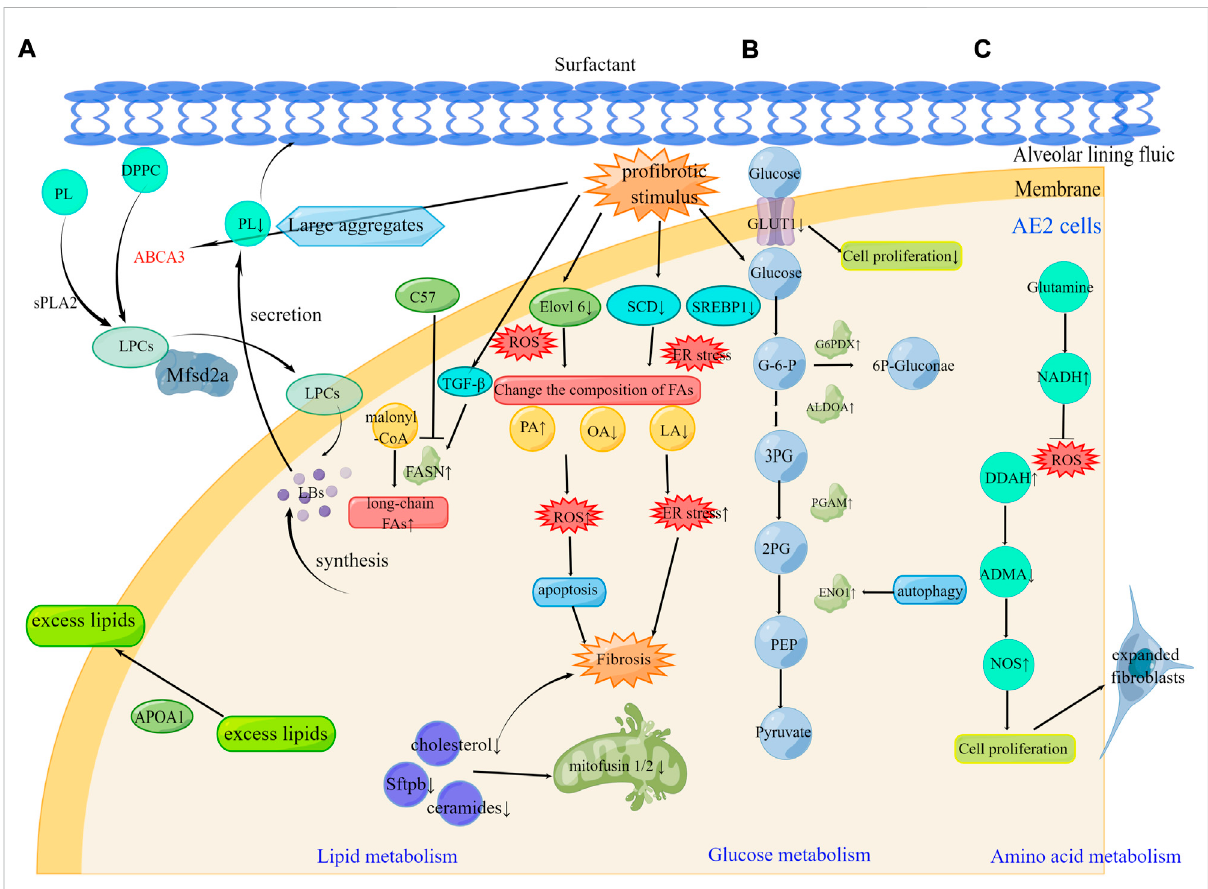
FIGURE 2 Metabolic reprogramming of AE2 cells in pulmonary fi brosis (A) . Alteration of FAs composition leading to ER stress and ROS, abnormal lipid uptakeonthelung surface, andreduced lipidproductioncaused bymitochondrial destructionall contribute to fi brosis progression.The therapeutic targets Mfsd2a, FASN, and ApoA1 can be effective in the development of pulmonary fi brosis (B) . Under pro fi brotic stimulus, increased PGAM, ENO1, ALDOA, and G6PDX affect glucose metabolism. The therapeutic targets GLUT1 and ENO1 can be effective in the development of pulmonary fi brosis (C) . Under pro fi brotic stimulus, increased DDAH activity inhibited the NOS inhibitor ADMA contributing to the pool of expanded fi broblasts. The therapeutic targets glutamine and DDAH can be effective in the development of pulmonary fi brosis. DPPC, Dipalmitoylphosphatidylcholine; sPLA2, secreted phospholipase 2; LPCs, lysophosphatidylcholines; LBs, Lamellar bodies; SCD, stearyl CoA desaturase; SREBP1, sterol regulatory